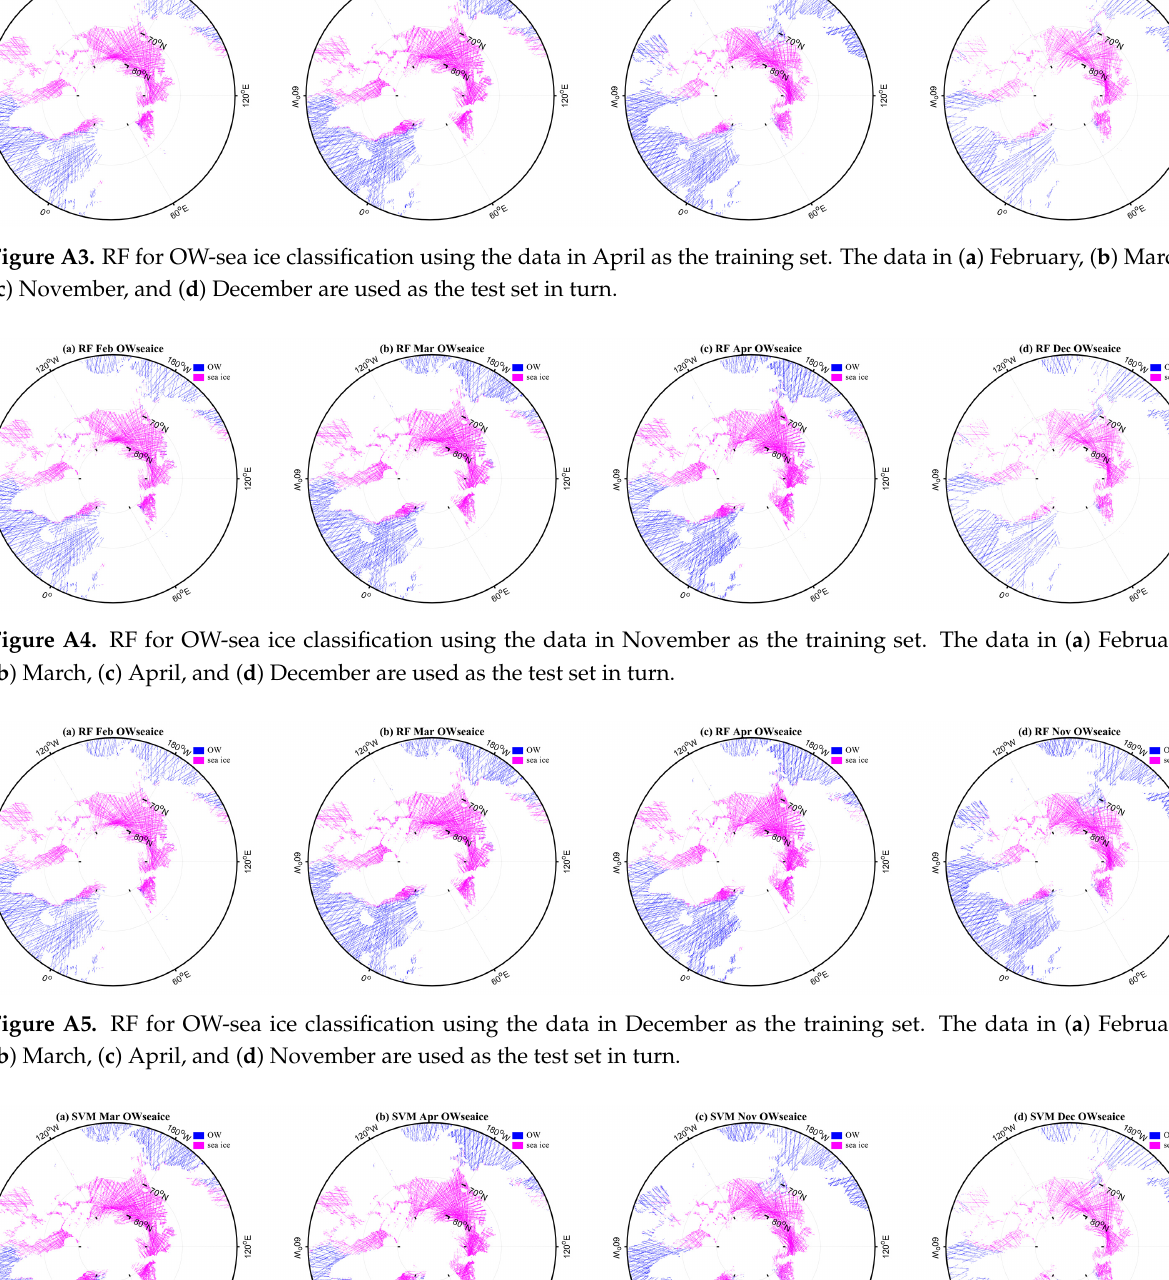
( c ) November, and ( d ) December are used as the test set in turn.